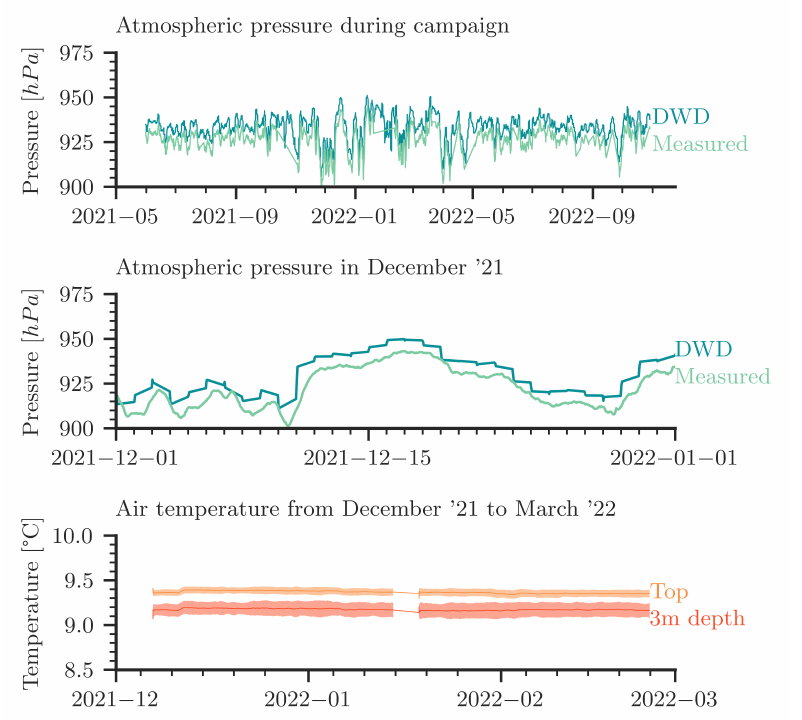
Figure A1. ( Top ): Comparison of our own measured atmospheric pressure with data from the DWD (“Deutscher Wetterdienst”). The DWD data is from Stötten (at a 25 km distance from Laichingen at almost the same altitude). ( Middle ): Exemplary detailed view in December 2021. ( Bottom ): Measured air temperature over time inside the cave; daily moving average and standard deviation. The data shown here are uncorrected raw data from temperature sensors; they indicate that within measurement accuracy the temperature is constant in time. From repeated control measurements (not shown), we have robust confirmation that there is no measurable temperature gradient from the top to the bottom of the